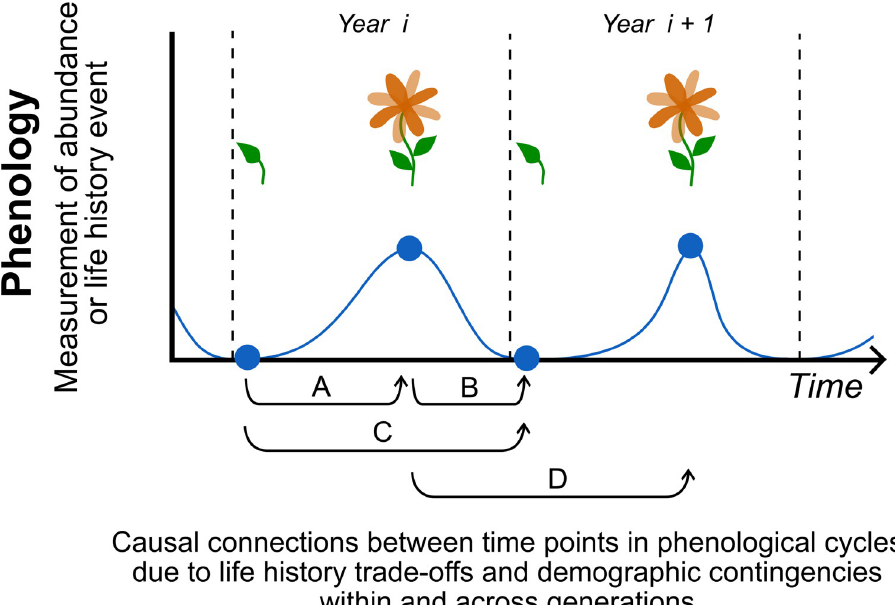
Fig 3. The manner in which phenology evolves at the single-species level requires consideration of trade-offs and temporal contingencies both within an individual’s lifetime and across generations. Phenology treated as a correlative response to meteorological forcing per year overlooks how evolution is shaped by trait covariance and demographic lag effects. Here, we illustrate 4 examples of connections in phenological cycles across 2 adjacent years or generations. Curve shows fluctuations in abundance or event timing (peaks) that are typical representations of phenology. Blue circles paired with pictoral representations of flower development denote points in the life cycle, and arrows indicate causal links between 2 points: (A) Biological functions early in life such as development and growth can be negatively correlated with those later in life such as reproduction. (B) Conversely, reproductive investment in 1 generation can influence the next generation’s offspring performance. Success of the previous generation can also shape the standing genetic variation available for selection in the next generation. (C) In some species, a proportion of offspring or seeds of a population will proceed to development while others enter diapause. These unrealized offspring carry over to subsequent years and influence population dynamics and selection landscapes in the future. (D) If the timing of a phenological trait such as flowering is related to fitness in the context of the environment, selection can shape the frequency distribution and its mean in the population, balanced out by potentially antagonistic forces such as those connections represented by A, B, and